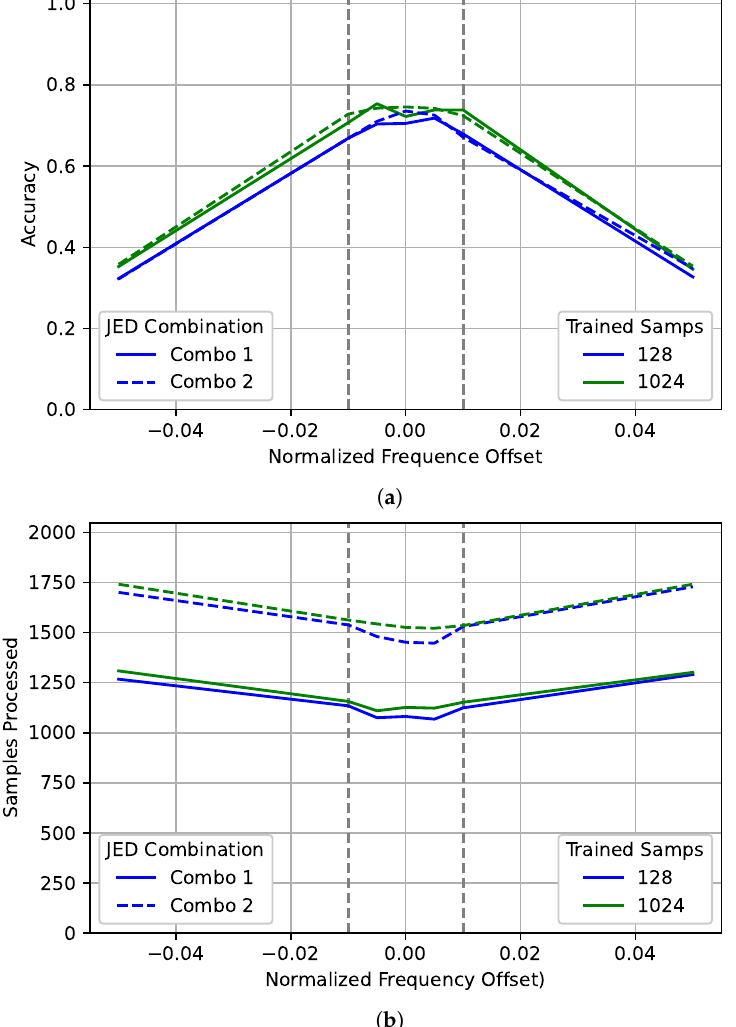
Figure 15. An examination of the ( a ) accuracy and ( b ) the number of samples processed of JED for different normalized frequency offsets. The best model for 128 and 1024 are each shown after processing with two different JED combinations. The gray dotted lines show the training range the frequency